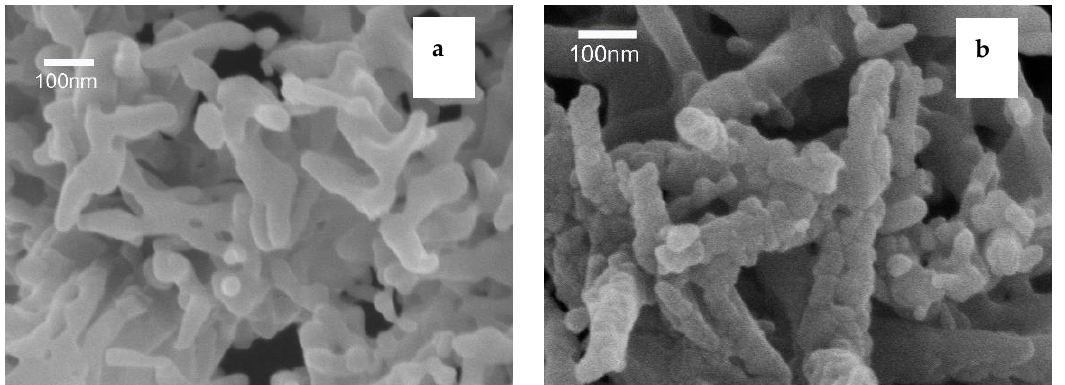
9 of 11 Figure 10. Emission spectra under an excitation wavelength of 398 nm of the Ca 0.97 TiO 3 :Eu 3+0.03 synthesized by the traditional sintering process (furnace) and microwave-assisted sintering process. Figure 11 shows the morphology of Ca 0.97 TiO 3 :Eu 3+0.03 phosphors (best doping) synthesized by the different synthesize methods and scanned by SEM. It can be seen from Figure 11a,b that both of